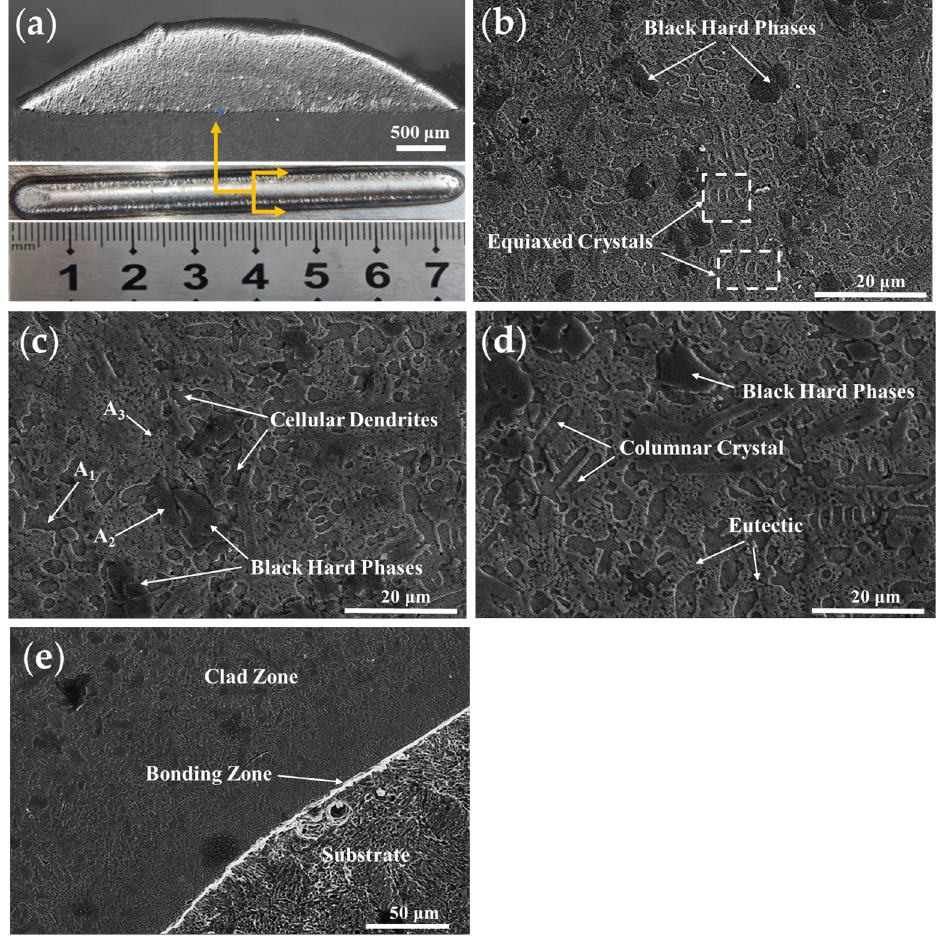
Figure 13. Morphologies of different regions under optimal process parameters. ( a ) Cross-section morphology; ( b ) top microstructure; ( c ) middle microstructure; ( d ) bottom microstructure; ( e ) mi- crostructure of bonding zone.